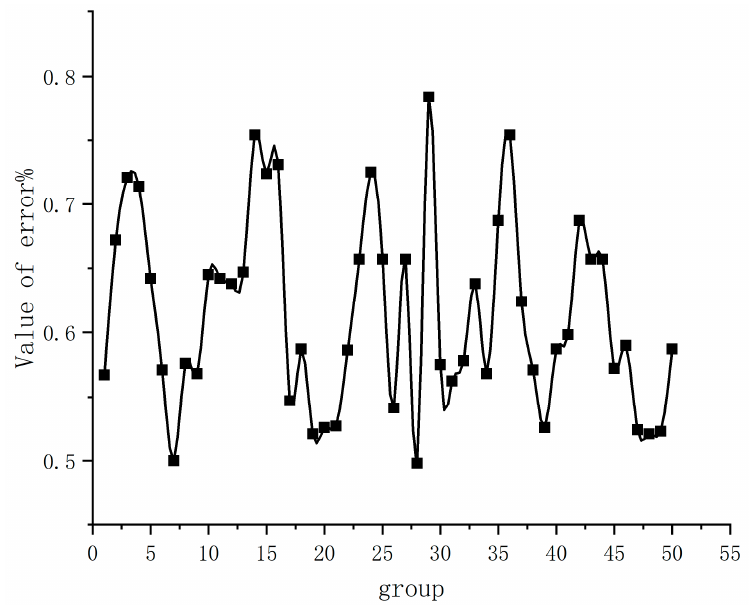
Figure 14. Error rate of flower tilt angle measurement.